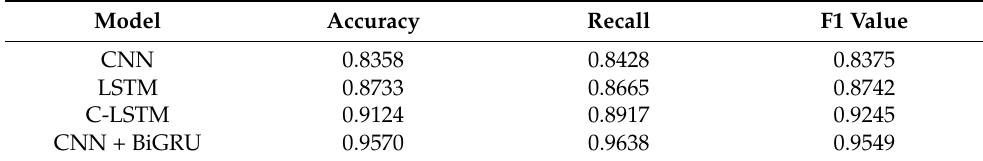
Table 7. Experimental Index Score.